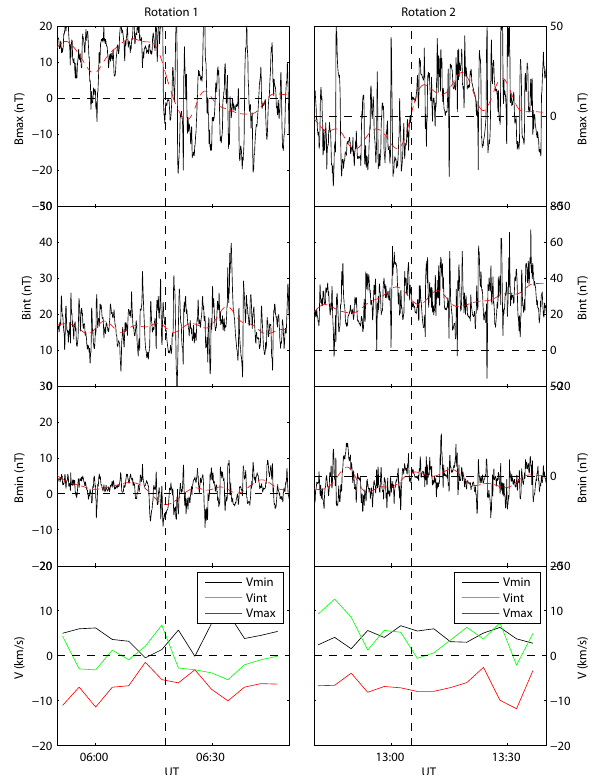
Figure 6. Zoom in on the two B -field rotations 1 (left) and 2 (right). Each column showing the magnetic field data in MVA coordinates: B max , B int and B min , the black lines show the data and the red lines show the low-pass filtered data. The bottom panel shows the IES ion velocities in MVA coordinates. The vertical dashed line shows the B max = 0